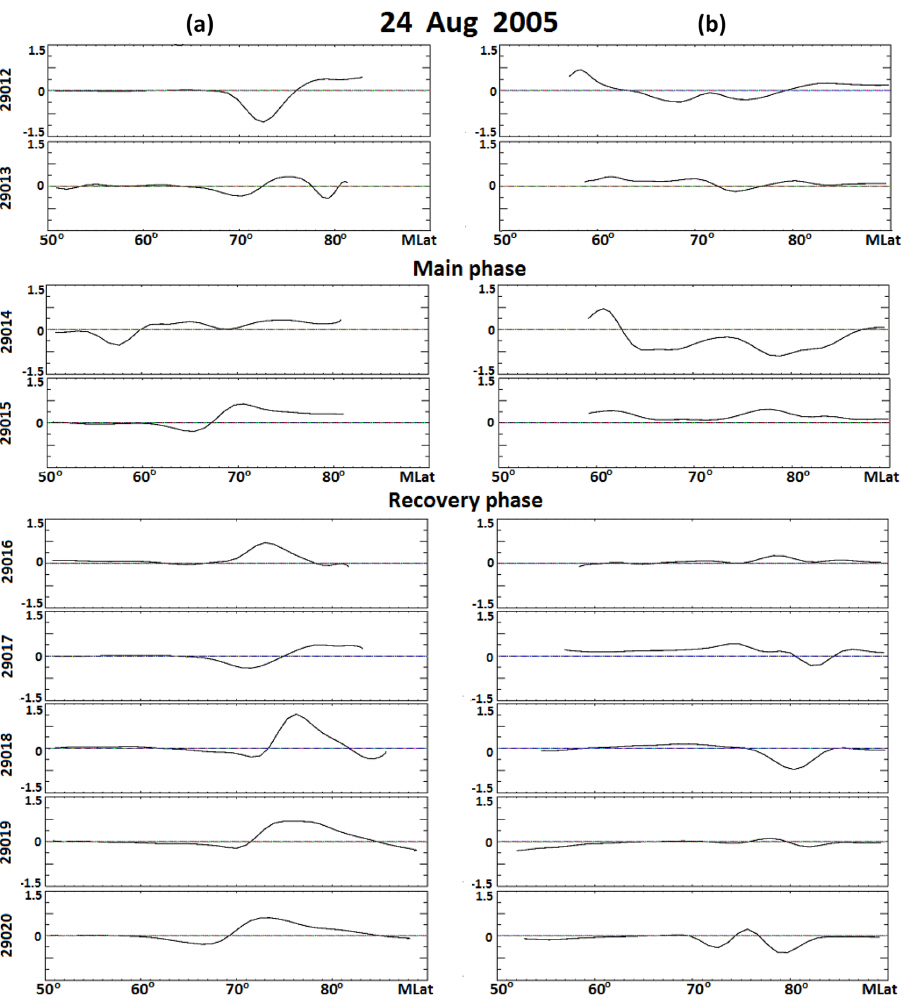
Figure A2. Direction and intensity values of the Hall current along the satellite orbit at the dayside ( a , 11:00–13:00MLT, corresponding to the ascending section of the orbit) and nightside sectors ( b , 23:00–24:00MLT, descending orbit section). Positive currents denote an eastward current for the descending orbit section and a westward current for the ascending section,